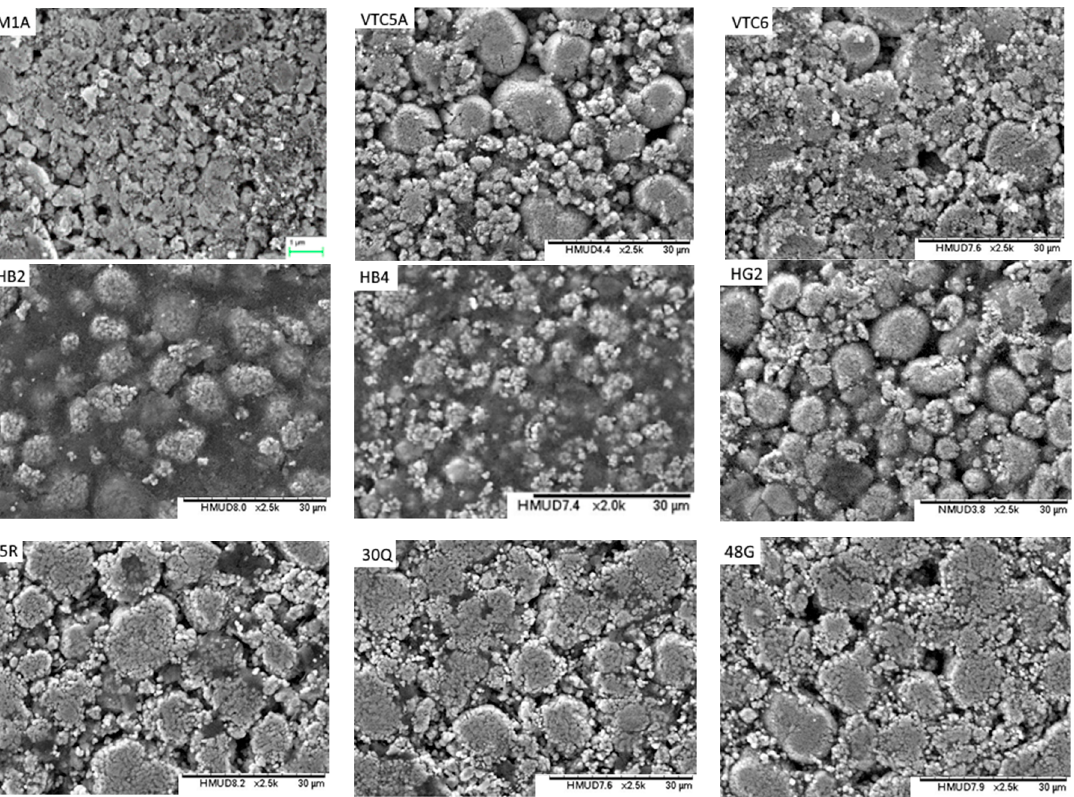
Figure 9. SEM images of cathode coatings.